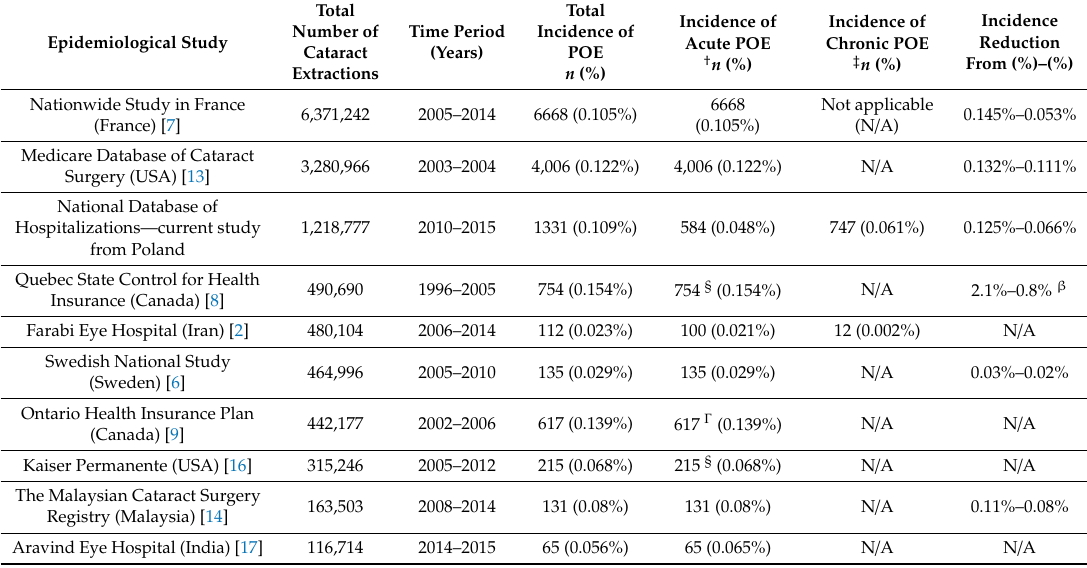
Table 6. Comparison of the incidence rates of postoperative endophthalmitis (POE) from recent studies which comprised over 100,000